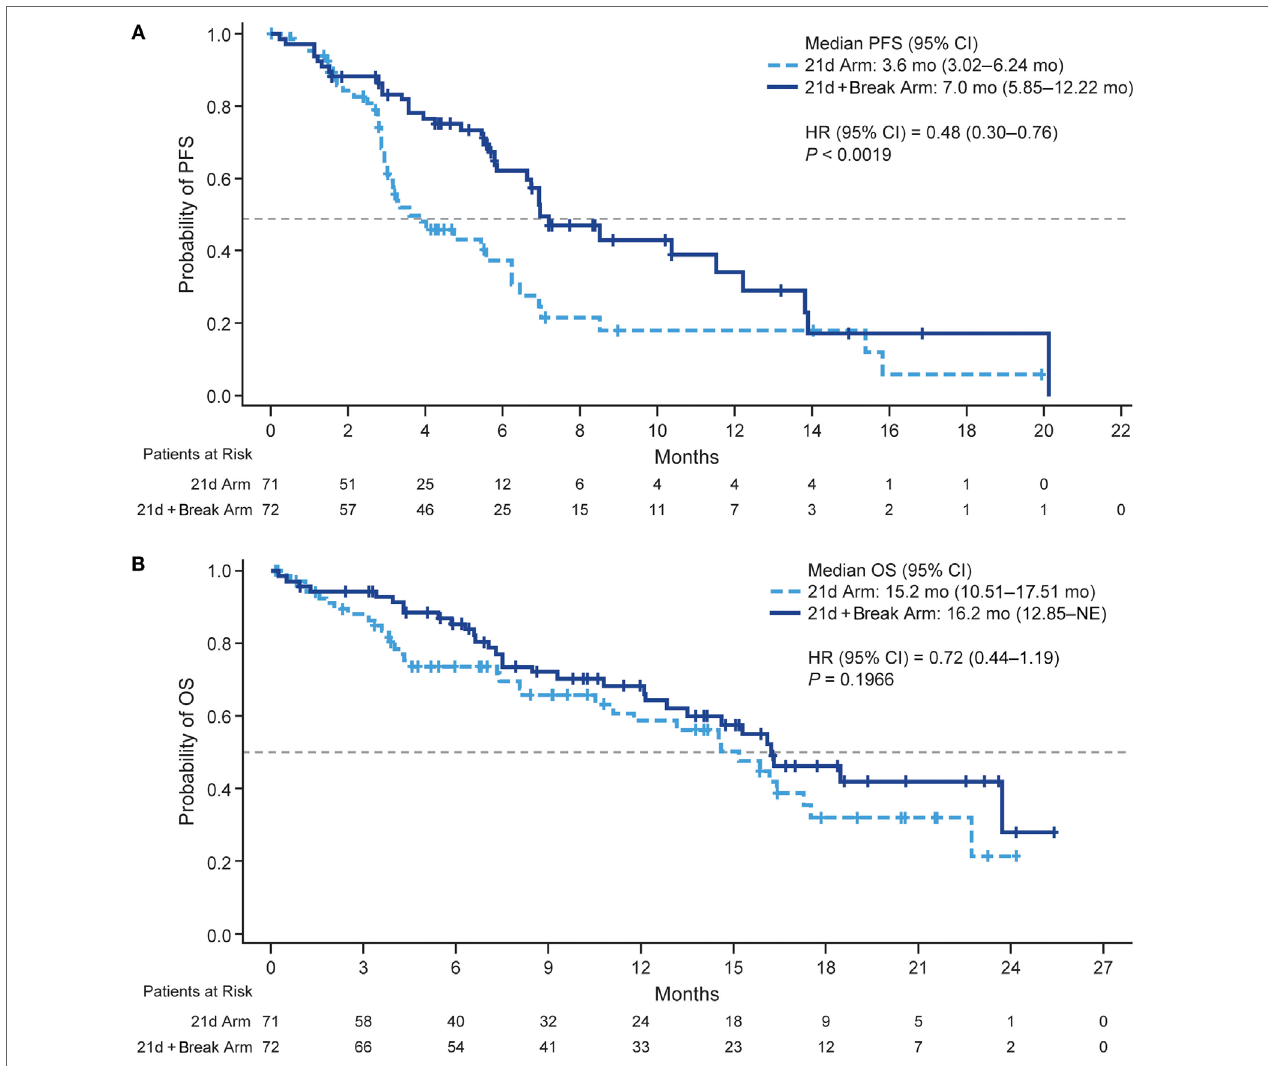
FigUre 2 | Kaplan–Meier plots of PFS and OS. (a) PFS. (B) OS. Abbreviations: HR, hazard ratio; NE, not estimable; PFS, progression-free survival; OS, overall